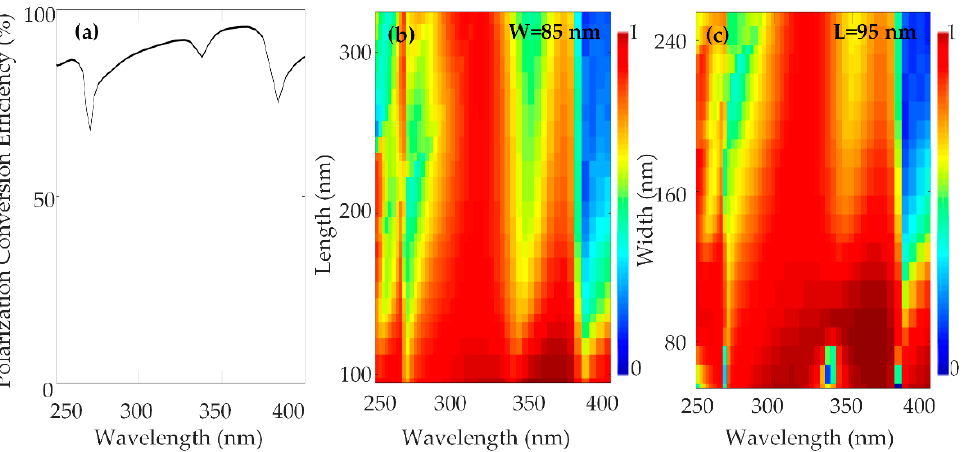
Figure 2. ( a ) Simulated polarization conversion e ffi ciency as a function of wavelength for which periodic boundary conditions were applied in x and y directions and perfectly matched layer boundary conditions were applied in the z-direction. ( b ) Polarization conversion e ffi ciency as a function of wavelength and length of the nanorod at width, W = 85 nm ( c ) Polarization conversion e ffi ciency as a function of the wavelength and width of the nanorod at length, L = 95 nm.